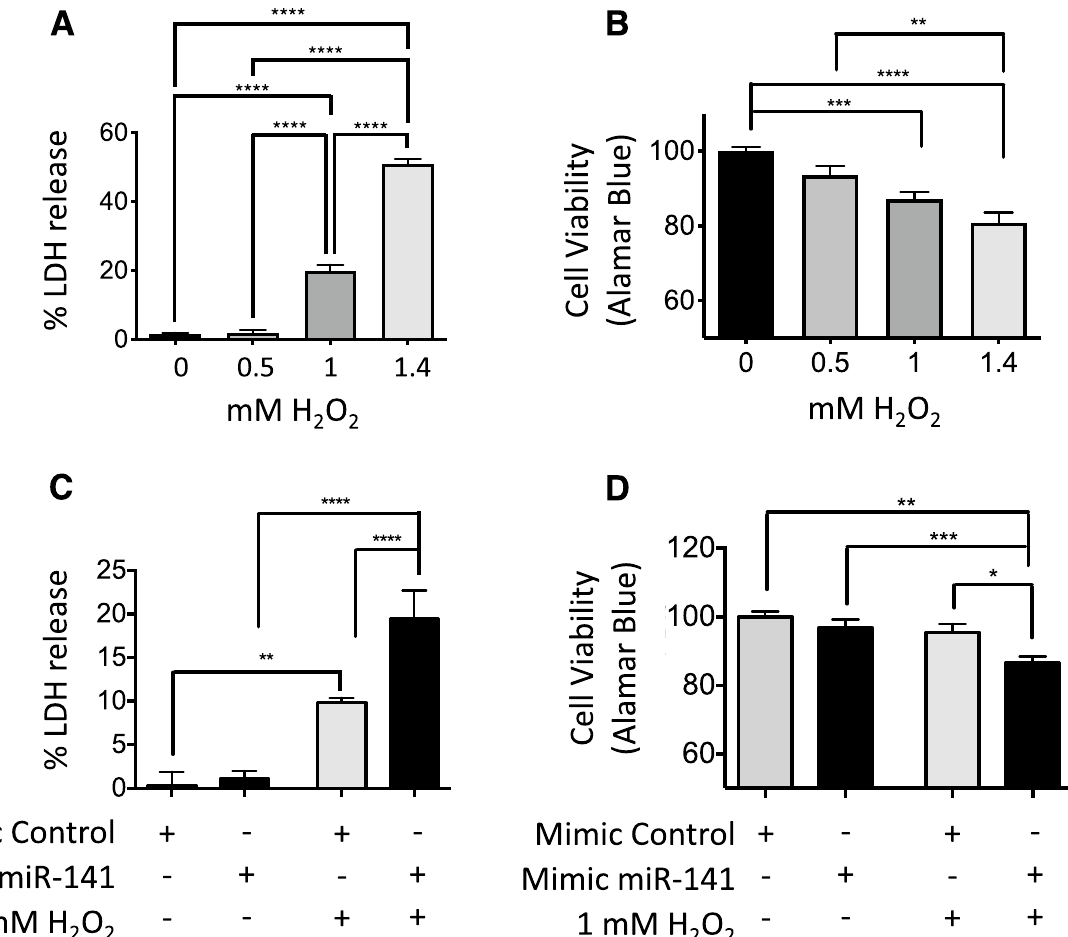
Figure 5. PTEC analysis in vitro: cell death and cell viability under oxidative stress, and manipulation of miR-141 expression. ( A ) Cell death marker lactate dehydrogenase (LDH) increased significantly at 1 mM and 1.4 mM H 2 O 2 . ( B ) Cell viability marker Alamar Blue showed 10% and 20% fewer viable cells in 1 mM and 1.4 mM